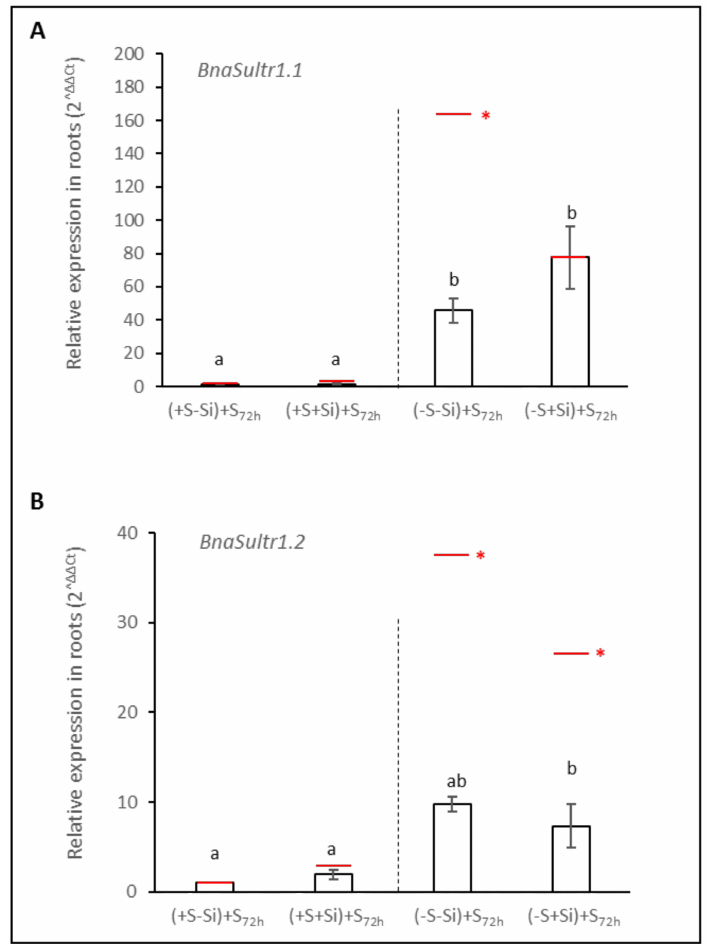
Figure 6. Relative expression of genes encoding the sulfate transporters BnaSultr1.1 ( A ) and BnaSultr1.2 ( B ) in roots of Brassica napus L. at D21 + 72 h: plants were previously cultivated in hydroponic conditions for 21 days with (+S; 500 µ M) or without sulfur (–S; 0 µ M) concentrations and with (+Si; 1.7 mM) or without Si supply (–Si) and then were resupplied with S for 72 h (+S 72h ; 500 µ M). Data are means ± SE (n = 4). Different lowercase letters indicate that means are significantly different ( p < 0.05). For each treatment, red marks represent the relative expression of each gene observed in roots at 21 days (Figure 5). For each treatment and each gene, asterisks indicate significant differences ( p < 0.05) between the relative expression at D21 and at D21 + 72